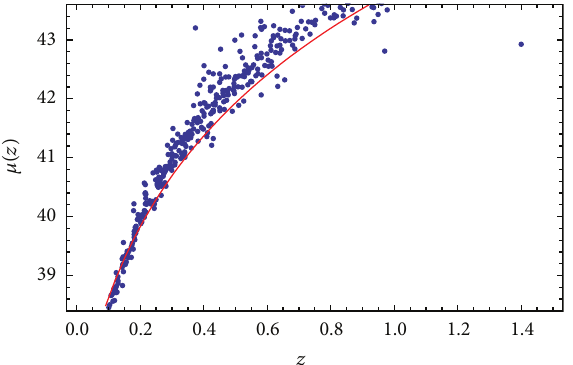
Figure 5: It shows the variation of distance modulus 𝜇(𝑧) versus redshift 𝑧 for our model (solid line) and the Union2 sample (dotted